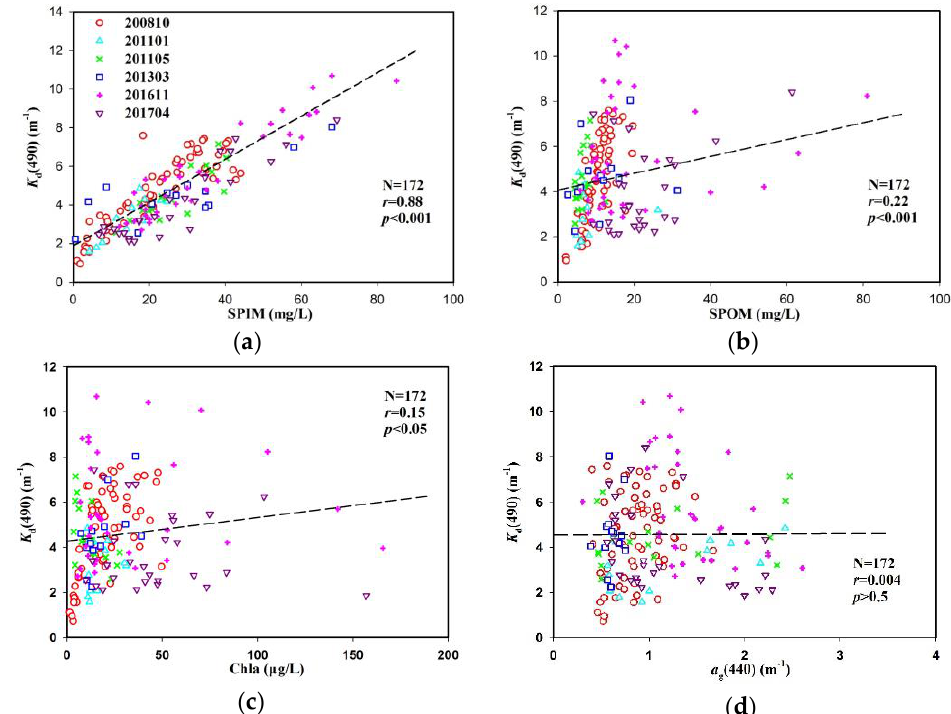
Figure 3. Relationships between K d (490) and the bio-optical parameters of the water: ( a ) SPIM; ( b ) SPOM; ( c ) Chla; ( d ) a g (440).